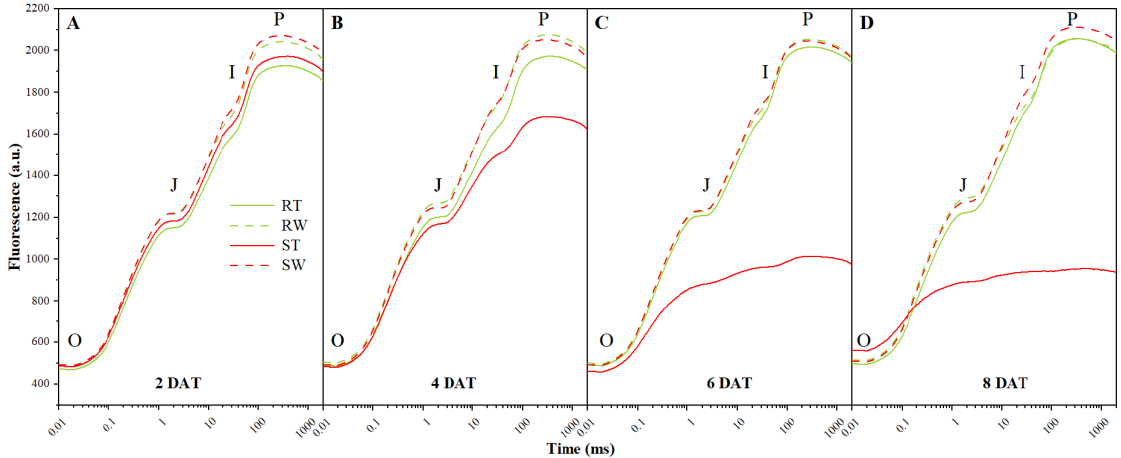
Figure 4. The OJIP transient curve of two maize cultivars (glyphosate-sensitive and glyphosate-resistant) with two treatments (glyphosate and water) at ( A ) 2, ( B ) 4, ( C ) 6, and ( D ) 8 days after treatment (DAT) in Experiment 3. As for the marks of the four groups, “R” stands for “glyphosate - resistant”, “S” stands for “glyphosate - sensitive”, “T” stands for “with glyphosate”, and “W” stands for “with water”.